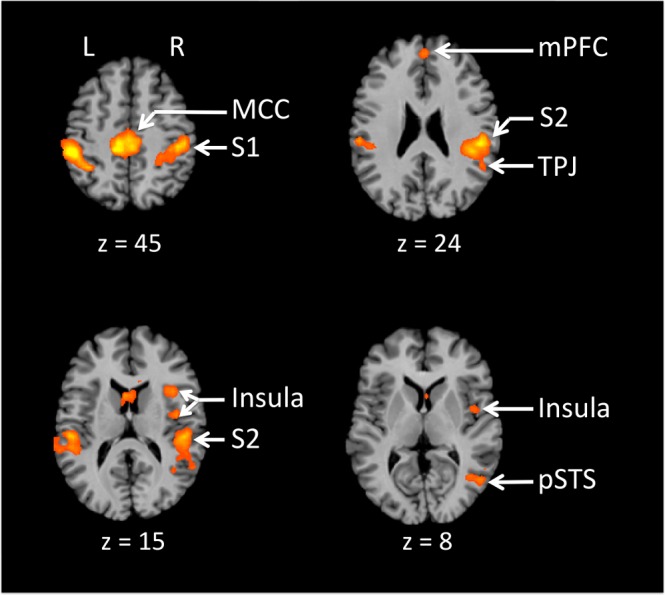
Main effect of partnering.Partnering was examined by contrasting the partnered conditions with the non-partnered conditions (Leading + Following + Mutual > Solo + Alone), with results reported at p < 0.05, FDR corrected, with a cluster threshold k = 20. The results in Figs 2–4 are registered onto a Talairach-normalized anatomical template MRI (the Colin brain). The Talairach z coordinate is shown below each slice. The left side of the slice is the left side of the brain. Abbreviations: MCC: middle cingulate cortex; mPFC: medial prefrontal cortex; pSTS: posterior superior temporal sulcus; S1: primary somatosensory cortex; S2: secondary somatosensory cortex; TPJ: temporo-parietal junction.